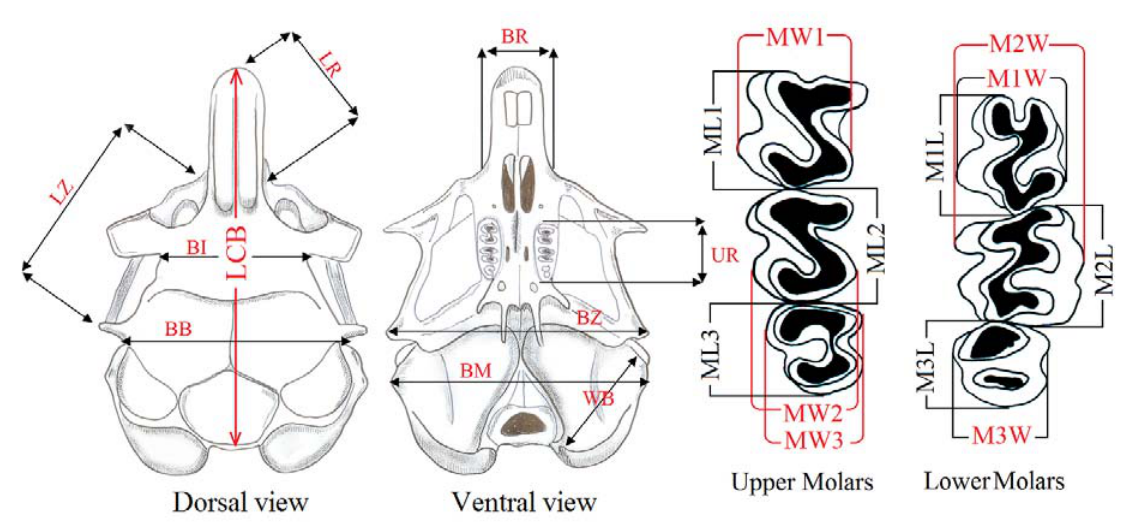
F IGURE 2. Cranial and dentalmeasured